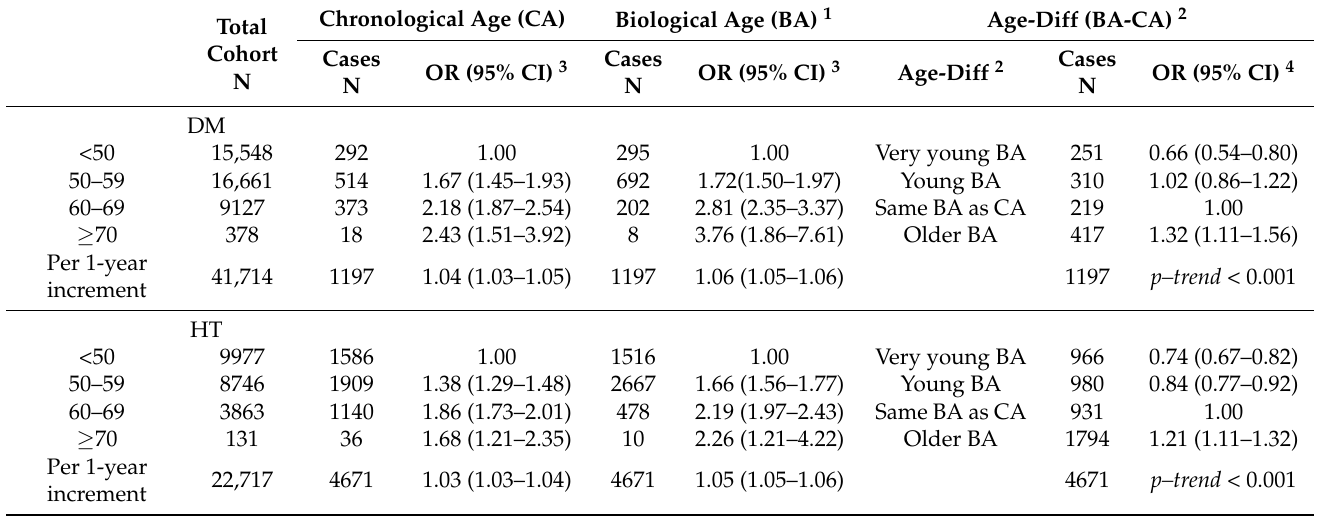
Table 3. Association with CA, BA, and Age-Diff on the risk of the development of DM, HT, combi- nation of DM and HT, and CKD on short-term follow-up periods ( ≤ 5 years) among 101,980 cohort participants in the